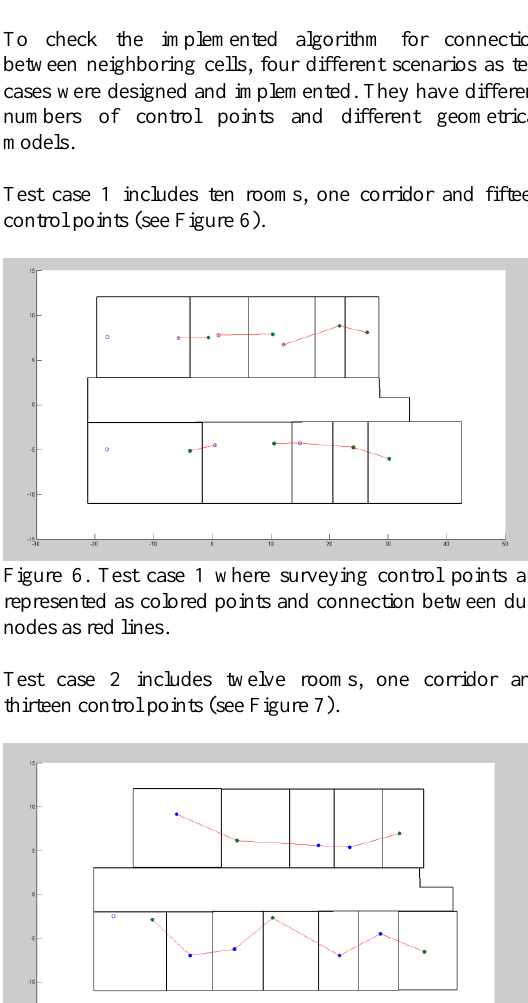
Figure 5. The proposed hybrid indoor space model where surveying control points are represented as green points, connection between dual nodes as blue lines, connection between rooms as blue dash lines and connection between floors as red lines.